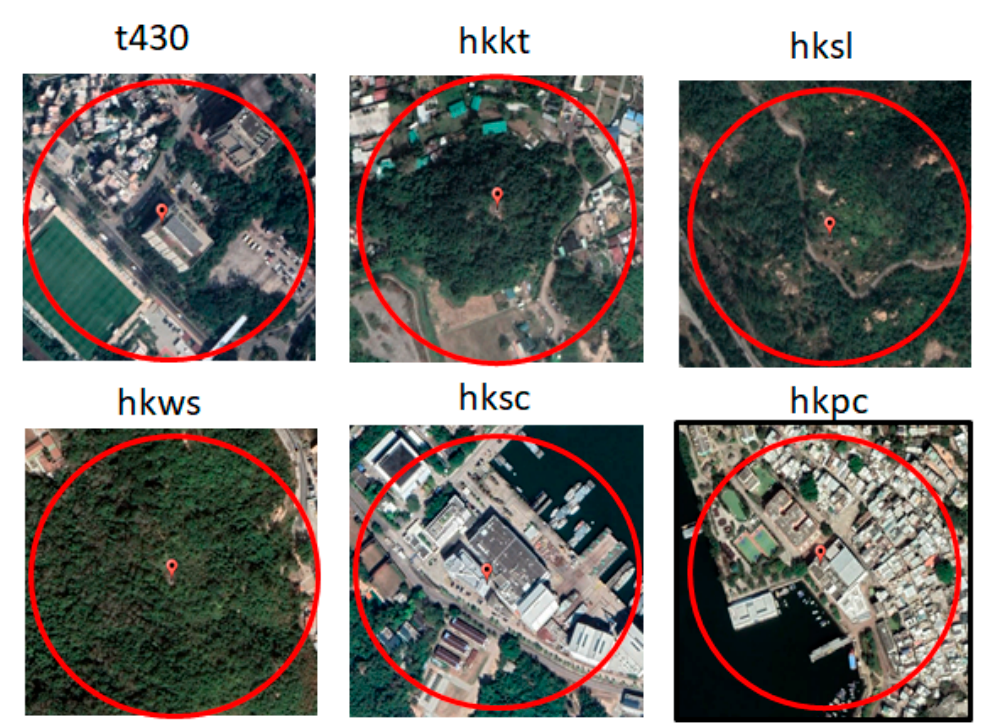
Figure A2. Surroundings of all GNSS and meteorological stations in Hong Kong, China.